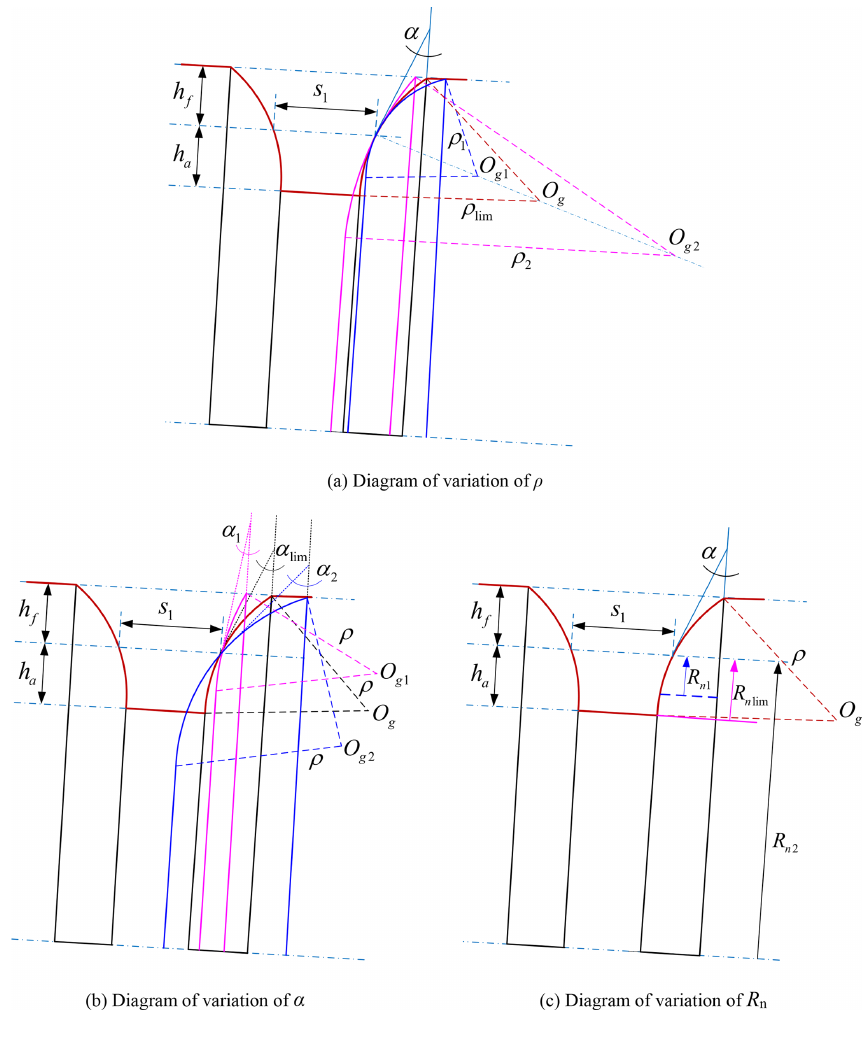
Figure 3. Geometric representation of the variation of the grinding wheel geometry